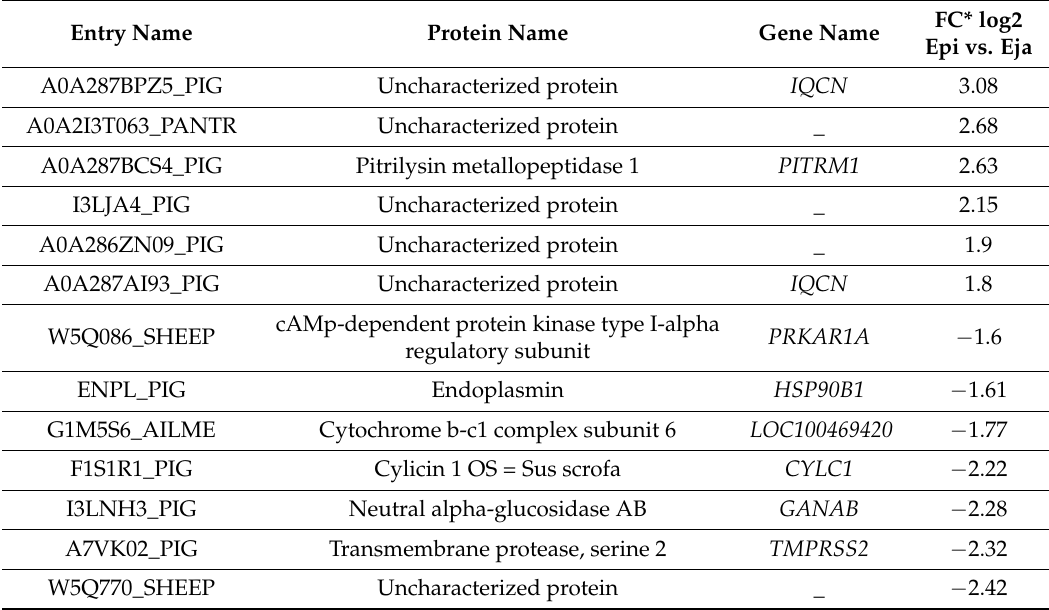
Table 4. Proteins differentially abundant between frozen-thawed pig spermatozoa from cauda epididymis (Epi) and ejaculate